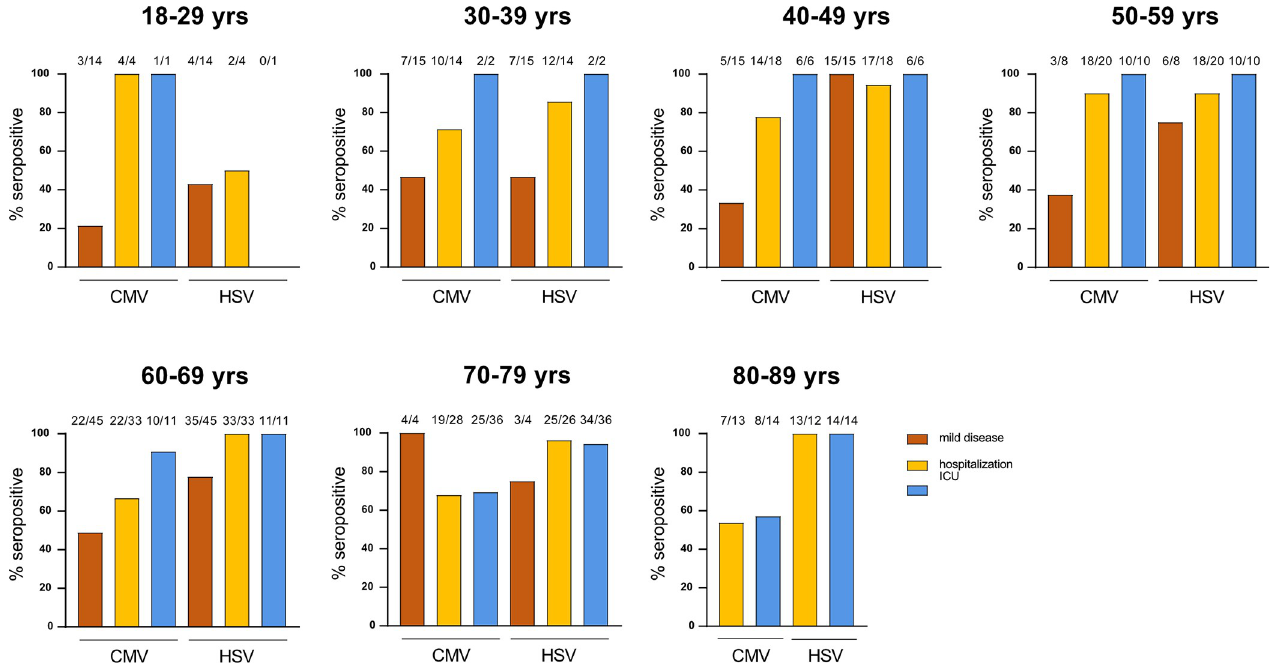
Fig 1. CMV serology associates with severity of COVID-19 in young individuals. CMV and HSV IgG titers were measured in serum collected from COVID- 19 patients that either suffered from mild disease or required hospitalization (ICU and non-ICU, or hospitalized). Shown are percentages of CMV- and HSV- positive individuals according to age and disease severity. Numbers above bars indicate the absolute number of seropositive subjects on the total number of individuals per subgroup.